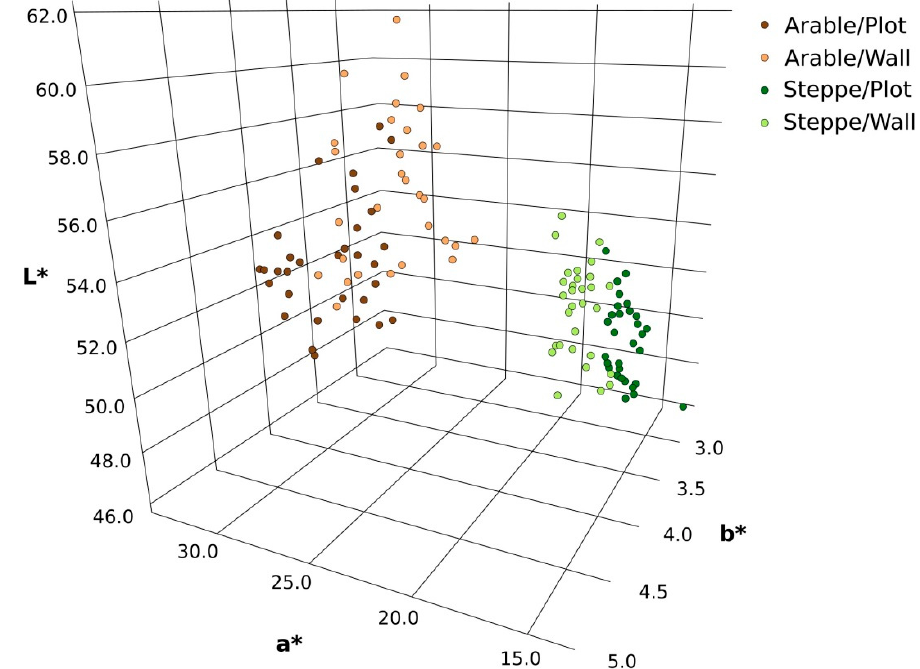
Figure 3. Position of soil samples in color space CIE 1976 (L*a*b*). Table 2. Descriptive statistics for color coordinate